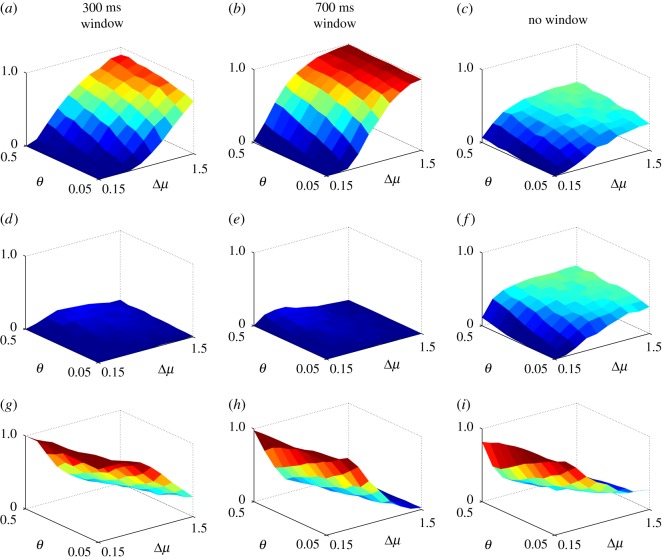
Performance of windowed and non-windowed MSPRT as a function of decision difficulty (defined by Δμ=μ+−μ−; see text) and threshold θ. The input protocol is that in equation (3.5). Panels (a–c) show the probability P, (fraction of 1000 experiments) of performing a correct decision at the end of the trial for each of the cases: 300 ms window, 700 ms and no window. Panels (d–f) show the corresponding probabilities of performing an incorrect decision. Panels (g–i) show the probabilities for reaching no decision at the end of the trial.